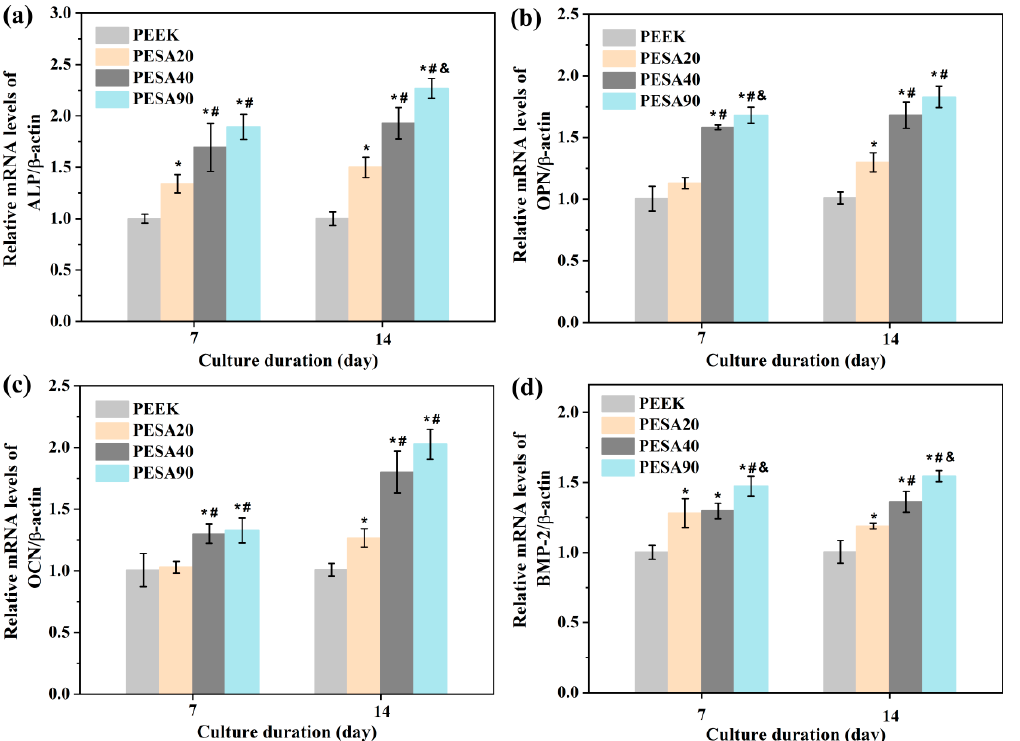
Figure 8. Osteogenic gene expression of MC3T3-E1 osteoblasts cultured on different samples at different time points (days 7 and 14) determined using RT-qPCR: ( a ) ALP, ( b ) OPN, ( c ) OCN, and ( d ) BMP-2. Statistically significant differences were indicated by * p < 0.05 compared with the PEEK, # p < 0.05 compared with the PESA20, and & p < 0.05 compared with the PESA40. All data represent the mean value ± standard deviation ( n = 3 per group).